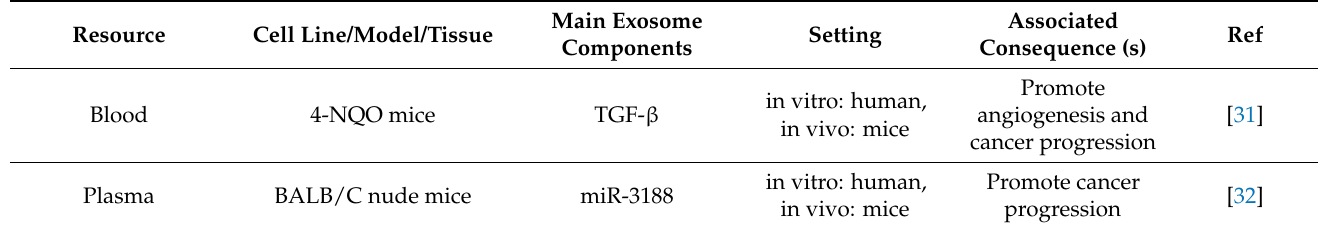
Table 1. The function of exosomes in